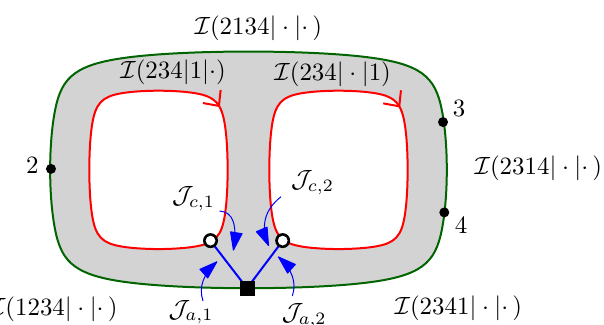
Figure 14 . Two-loop string amplitude with contours from eq. (5.2).